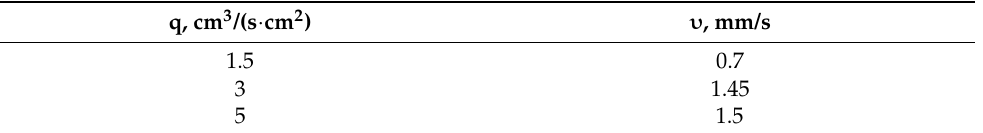
Table 1. Combustion rate of the sample (70% AlN + 30% Al) depending on the specific flow rate of nitrogen.